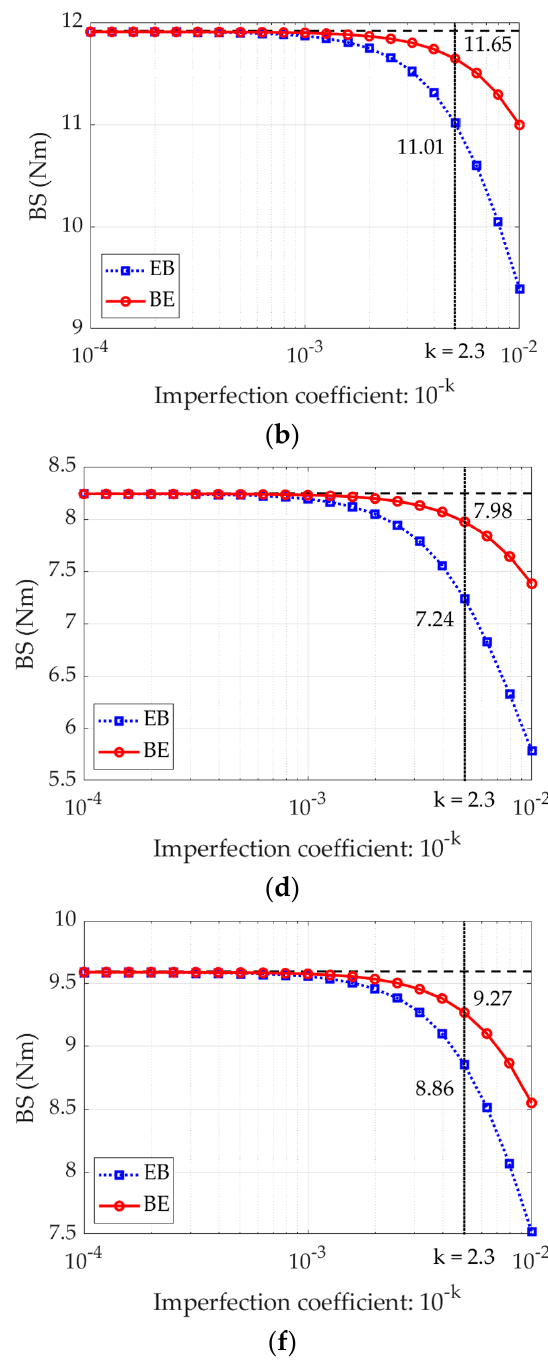
Figure 11. The dependence of BS on the imperfection parameter calculated using the EB model (with the E wave upwards) and by the BE model (with the B wave upwards): ( a ) Board 1; ( b ) Board 2; ( c ) Board 3; ( d ) Board 4; ( e ) Board 5; ( f ) Board 6.